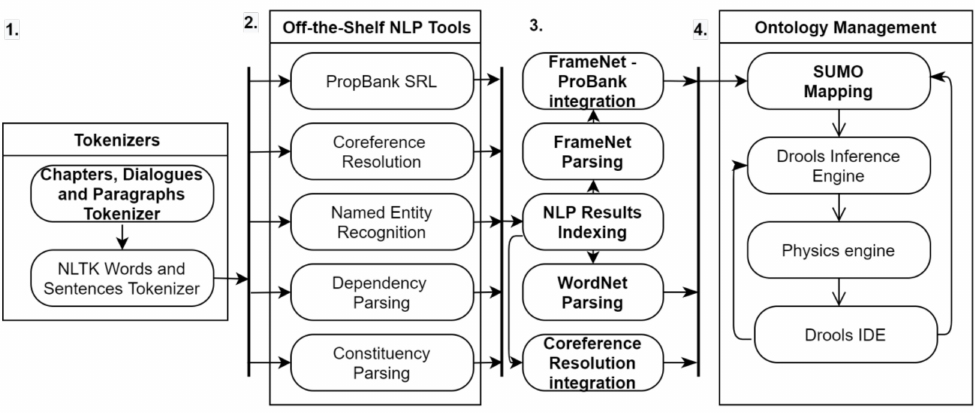
Figure 3. There are 4 main stages of the semantic parsing of fiction. Each NLP stage consists of several processes, separated by synchronization bars. The processes in bold indicate the algorithms that needed to be developed during this research